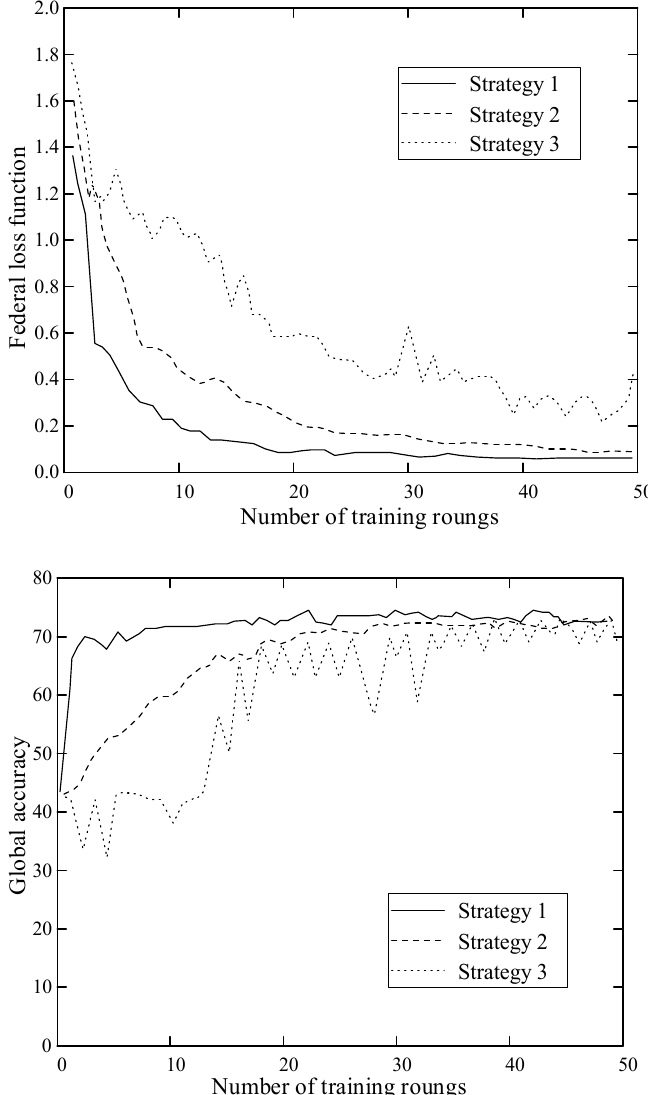
Figure 6. Effect comparison of node selection strategy.